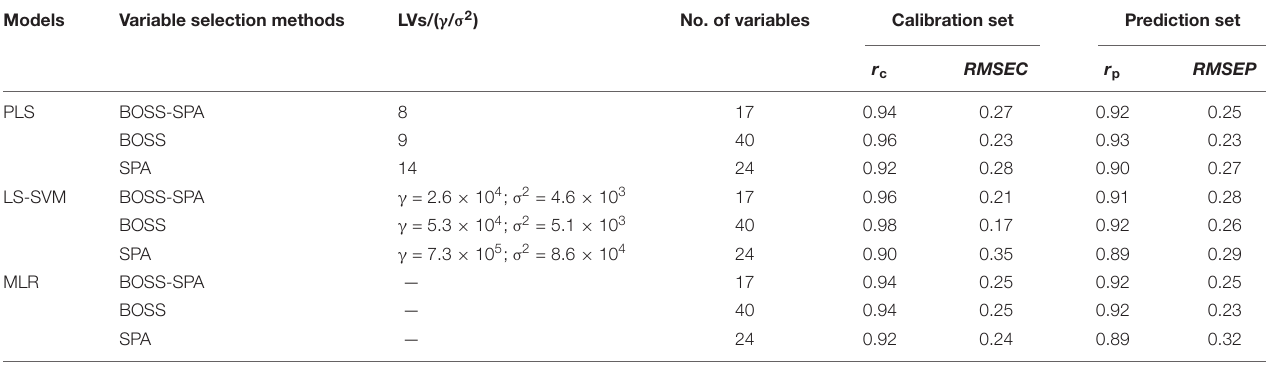
TABLE 4 | Prediction results of SSC by PLS, LS-SVM, and MLR models with different effective wavelengths.